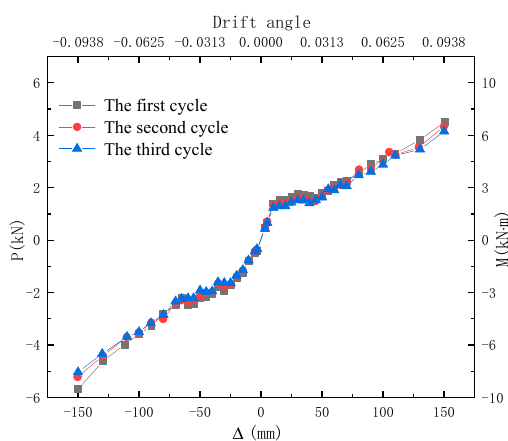
Figure 12. Load–displacement hysteresis curves.